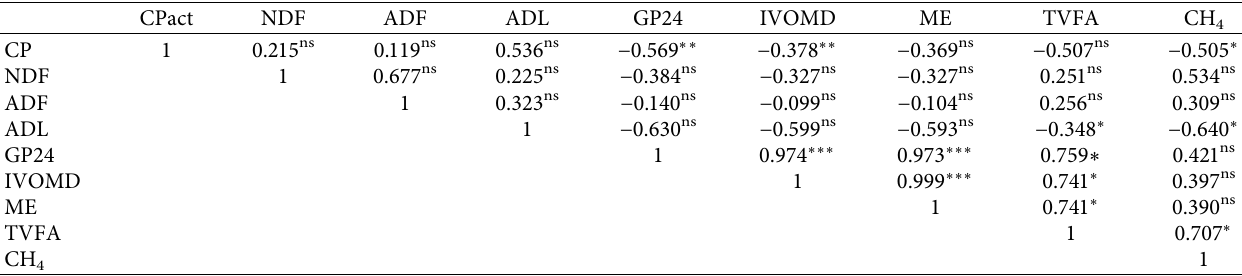
Table 5: Correlation between chemical composition, in vitro organic matter digestibility, and VFA production of forage grasses. GP24 ( r = − 0.569, P < 0 . 001), IVOMD ( r = − 0.378, P < 0 . 001), and methane production ( r = − 0.505, P < 0 .